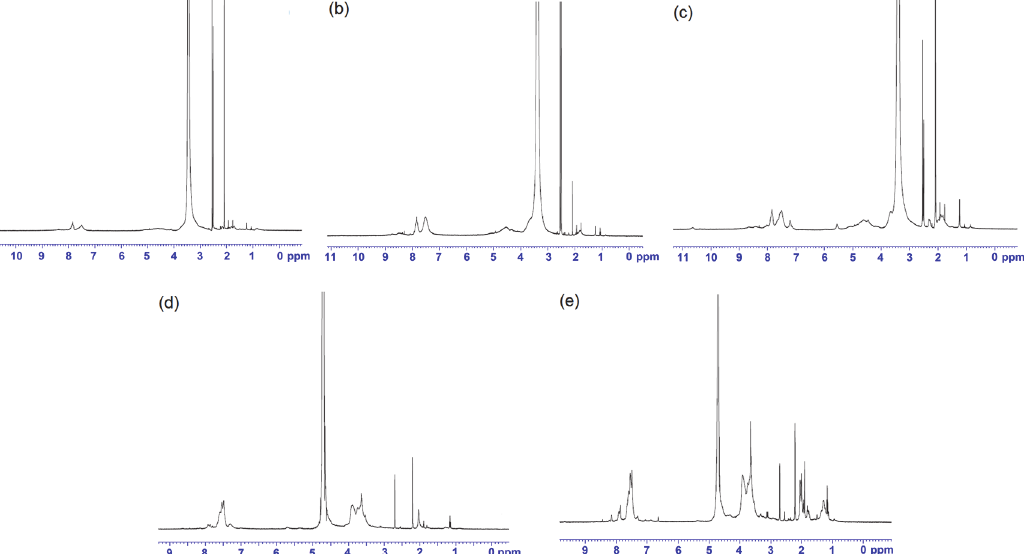
Fig 3. 1 H Nuclear magnetic resonance (1H NMR) spectra. Figure showing 1 Hnuclear magnetic resonance ( 1 HNMR) spectra of (a) derivative 1, (b) derivative 2, (c) derivative 3, (d) derivative 4, and (e) derivative 5.